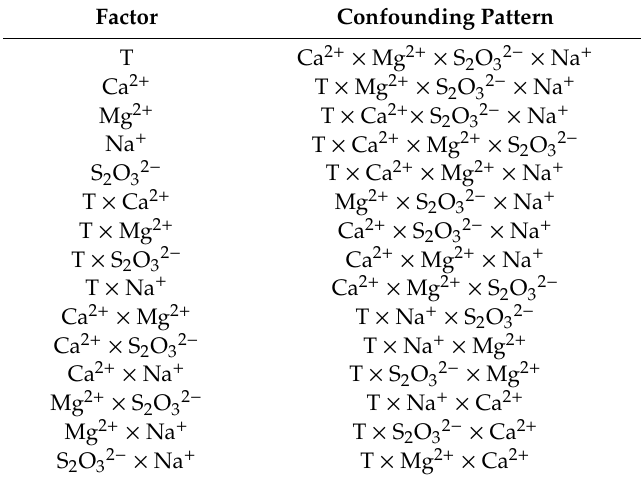
Table 3. Confounding of single factor and two factor interactions with their confounding patterns.